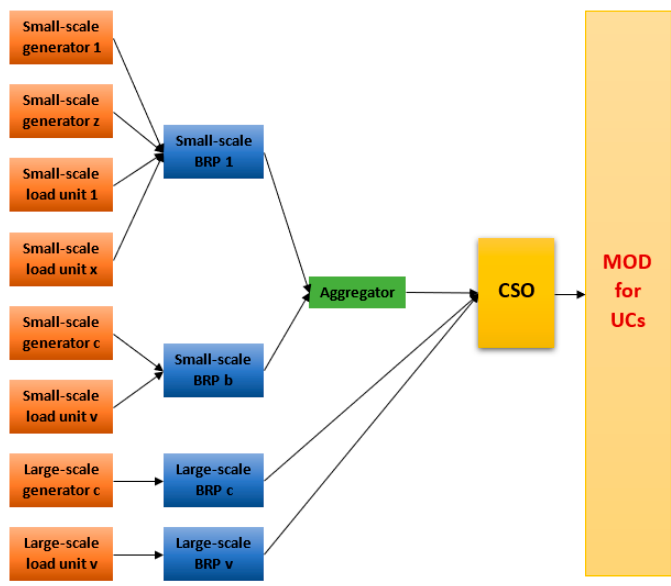
Figure 8. Interactions of actors in terms of data and information flows to exercise load and generation forecast activity [37].